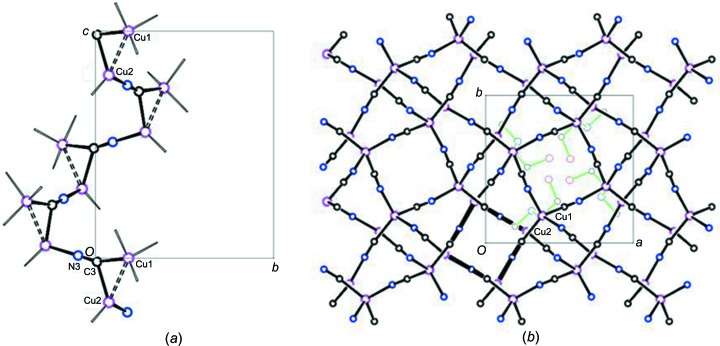
(a) Projection along the a axis of the spiral chain of Cu2(CN)5 and C3≡N3 units related by the 43 axis at x = 0, y = 0. Generic atom labels without symmetry codes have been used. (b) Packing diagram showing a projection along the c axis. The projection of the spiral chain shown in Fig. 4 ▸(a) is highlighted in bold. Only the cations within the unit cell are shown, with bonds drawn in green.